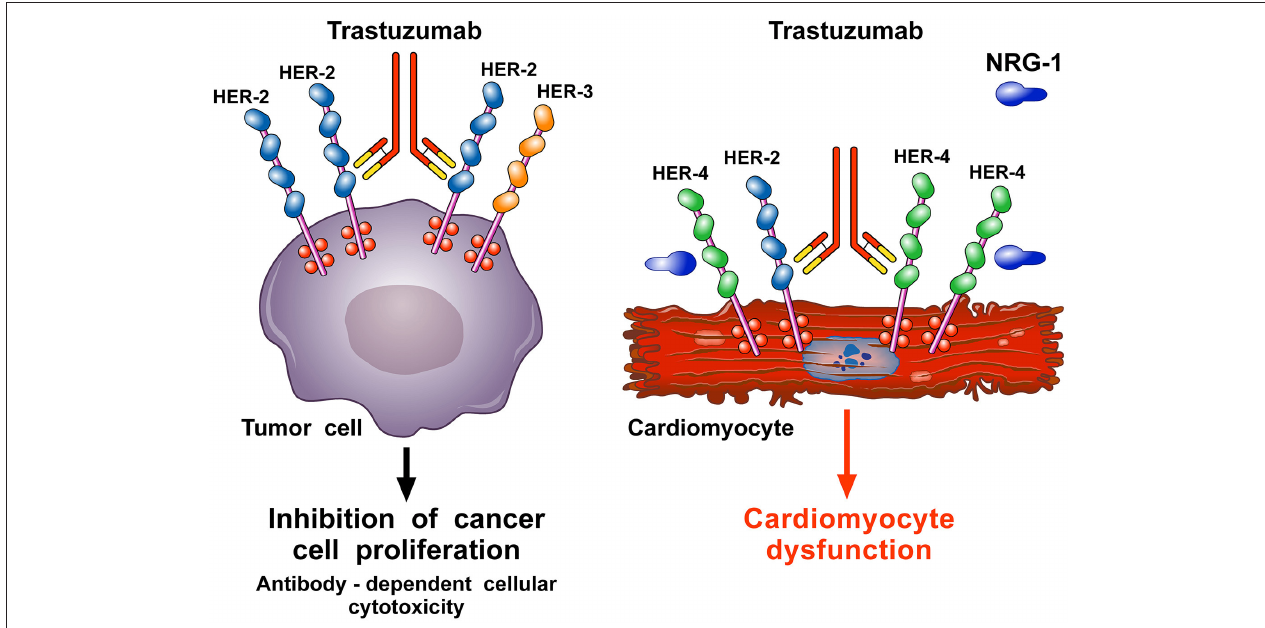
FIGURE 4 | Schematic representation of the mechanism of action of trastuzumab and pathogenesis of its cardiotoxicity. Trastuzumab is a mAb that binds the extracellular domain IV of HER-2. It is used to treat breast cancer patients ( ∼= 30%) in which HER-2 is overexpressed and spontaneously homodimerizes or forms heterodimers with other HER receptors, especially HER-3. This ligand-independent activation of HER-2 promotes proliferation and survival of tumor cells. Trastuzumab blocks the interaction HER-2/HER-3 and downstream signaling halting the growth of tumor cells. Moreover, trastuzumab induces the antibody-dependent immune cell-mediated cytotoxicity of cancer cells (left side) . In the heart, neuregulin-1 (NRG-1) triggers HER-4/HER-4 homodimerization and HER-4/HER-2 heterodimerization on cardiomyocytes to induce protective pathways in response to stress. Blockade of cardiac HER-2 by trastuzumab results in the disruption of NRG-1-dependent signaling and consequently in alterations of structure and functions that cause cardiomyocyte death (right side) .